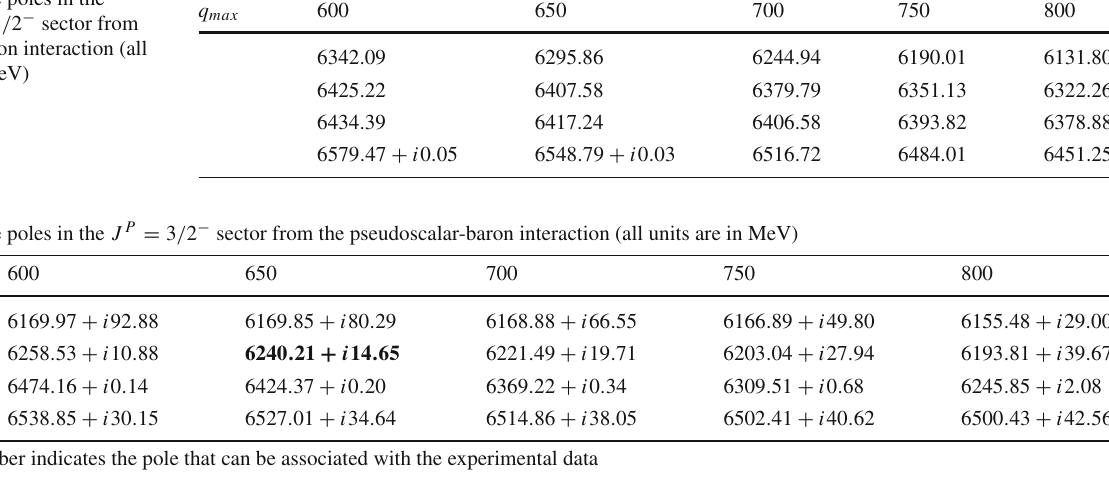
for the poles in the J P = 3 / 2 − sector with q max = 650MeV i